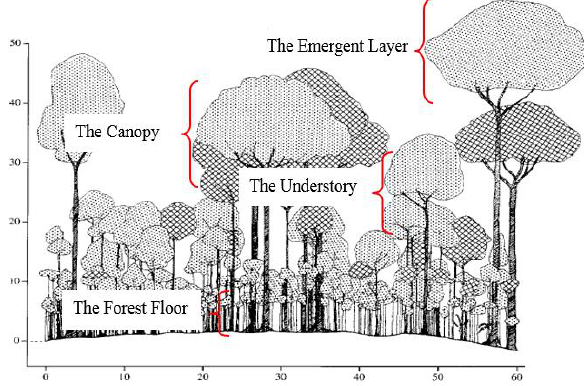
Figure 1. Profile diagram of Tropical rainforest (Turner, 1996)